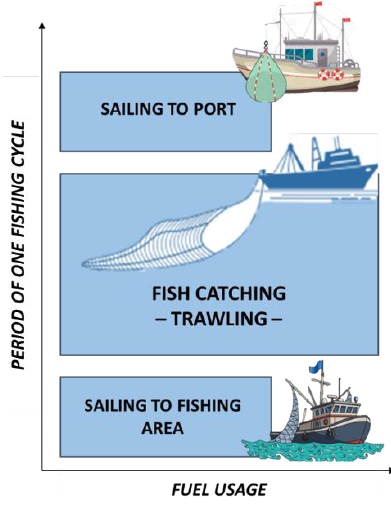
Figure 2. Fishing actions of trawlers.